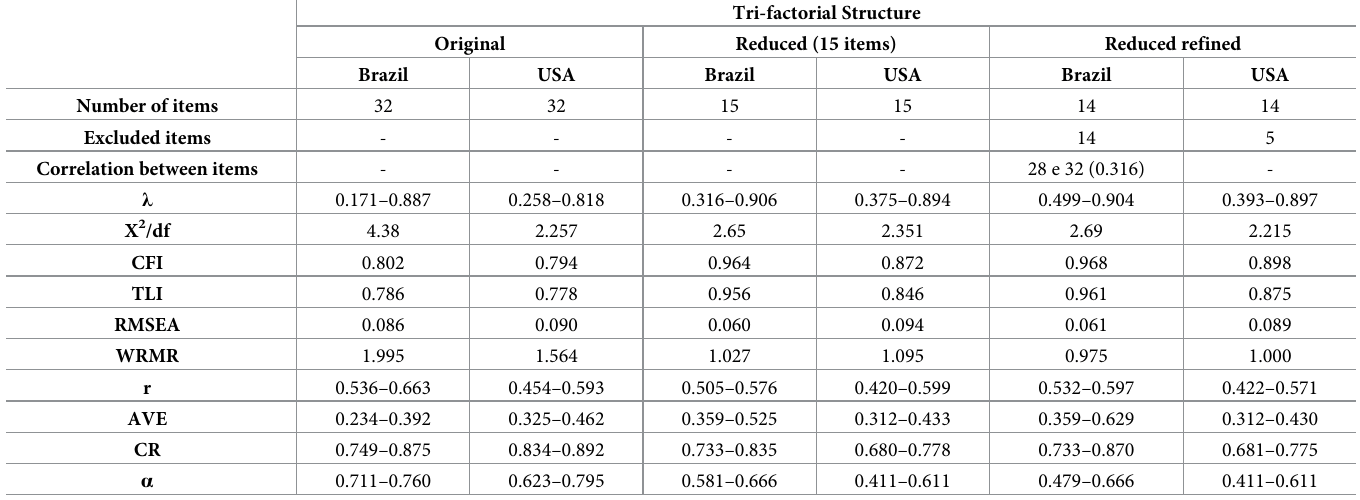
Table 2. Confirmatory factor analysis, average variance extracted (AVE), and reliability (composite reliability [CR] and α ) of the University Student Engagement Inventory (USEI) administered to dental students.